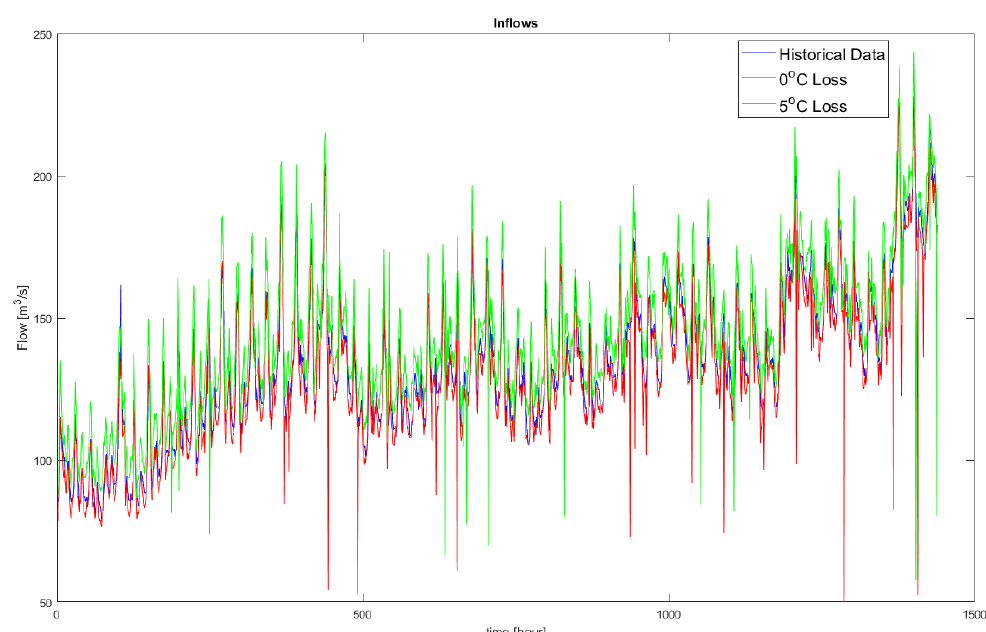
Figure 5. Historical supply flow (blue) vs. simulated flows for 0 ◦ C (red) and 5 ◦ C loss